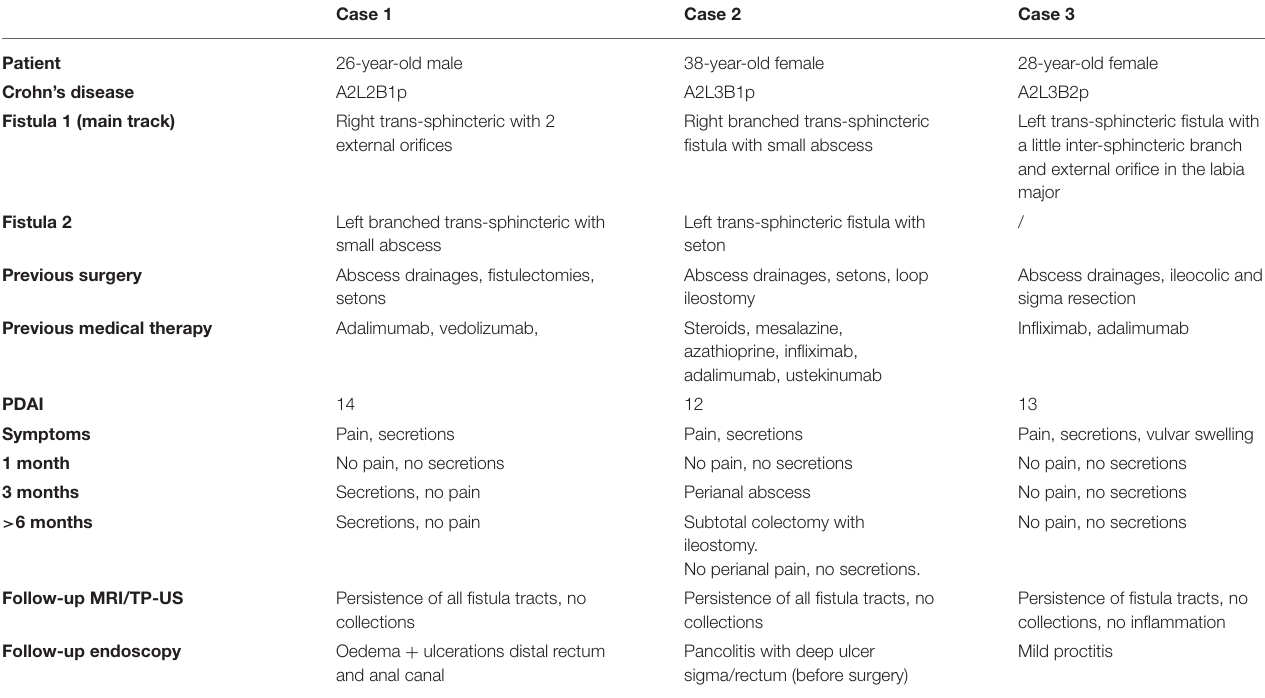
TABLE 1 | Characteristics and outcomes of perianal fistulizing disease treatment.